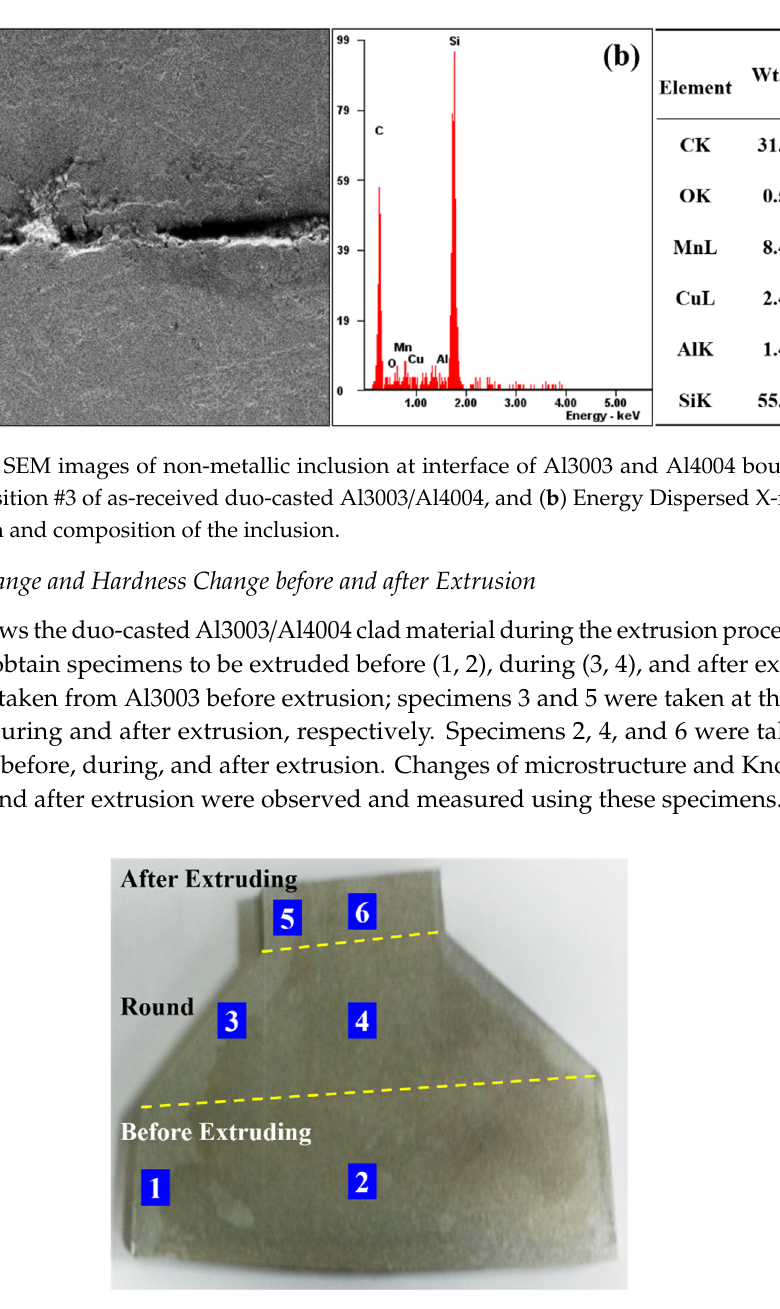
Figure 5. Shape of hydro co-extruded duo-casted Al3003/Al4004 and sampling positions with numbers (1,2: Before extruding/3,4: round/5,6: after extruding).